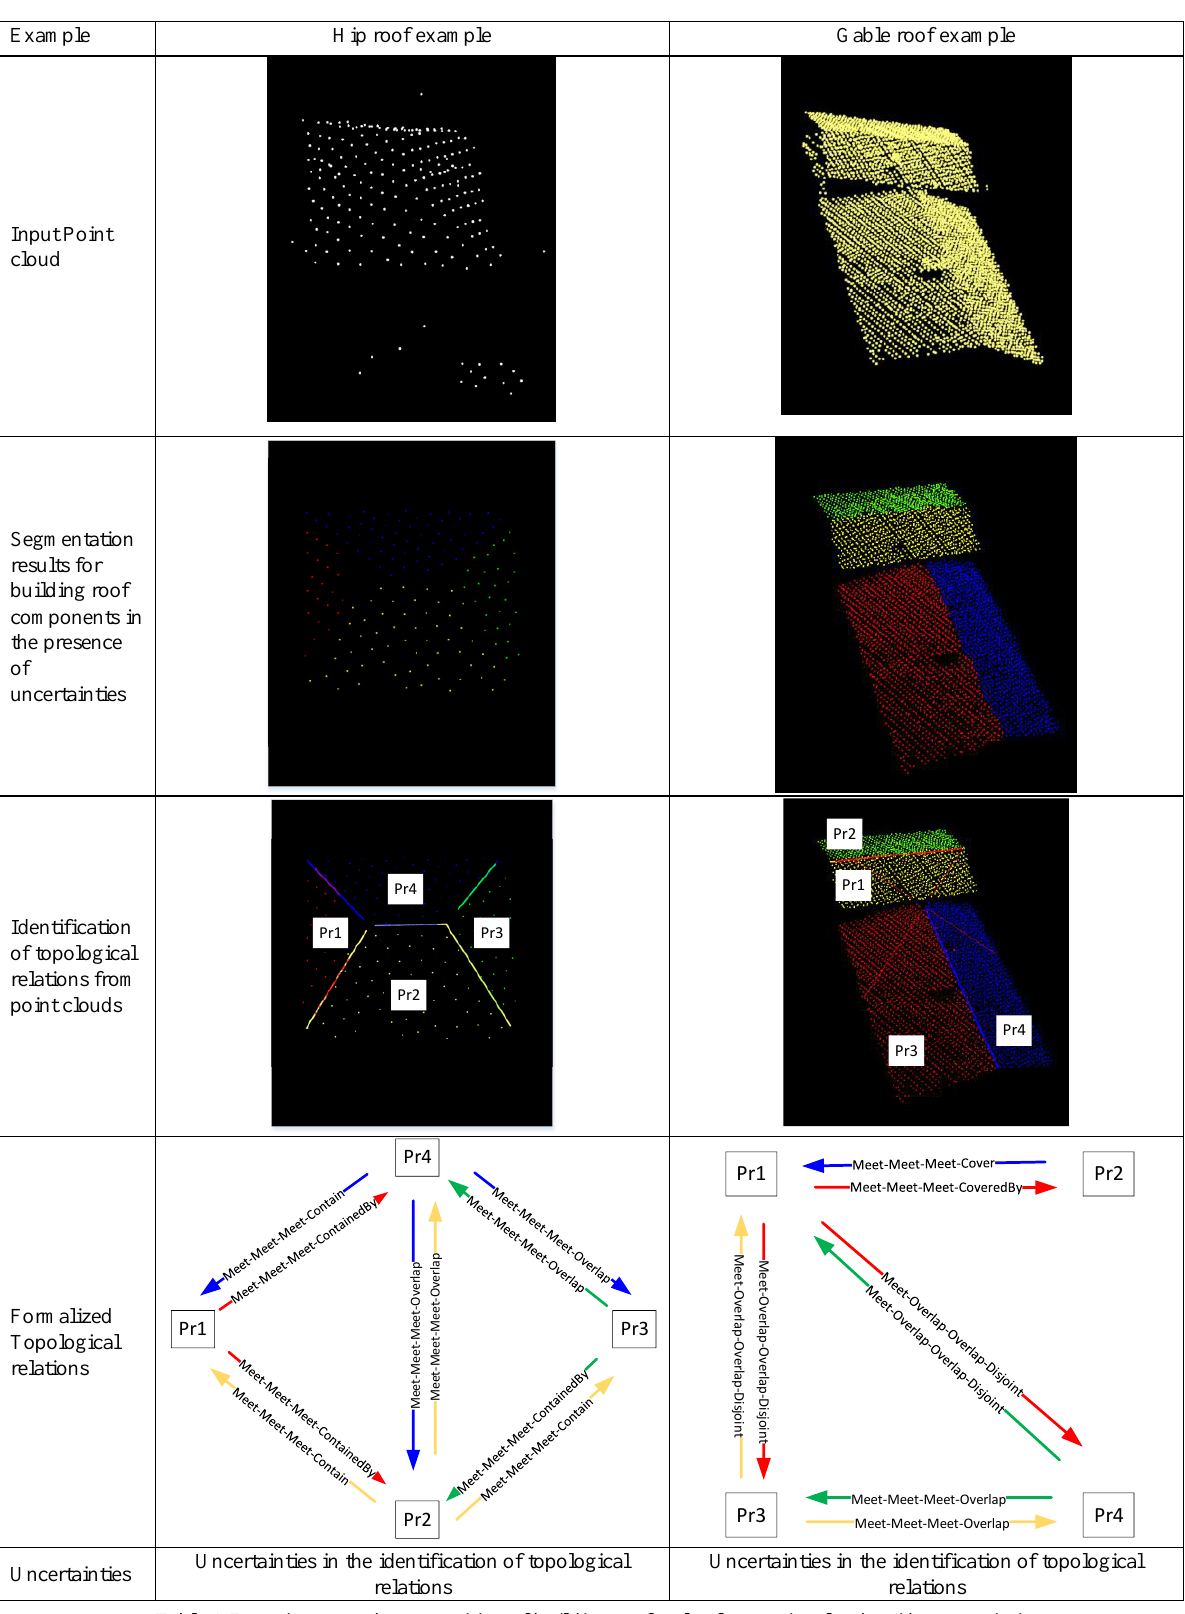
Table 3 Experiment on the recognition of building roof styles from point clouds with